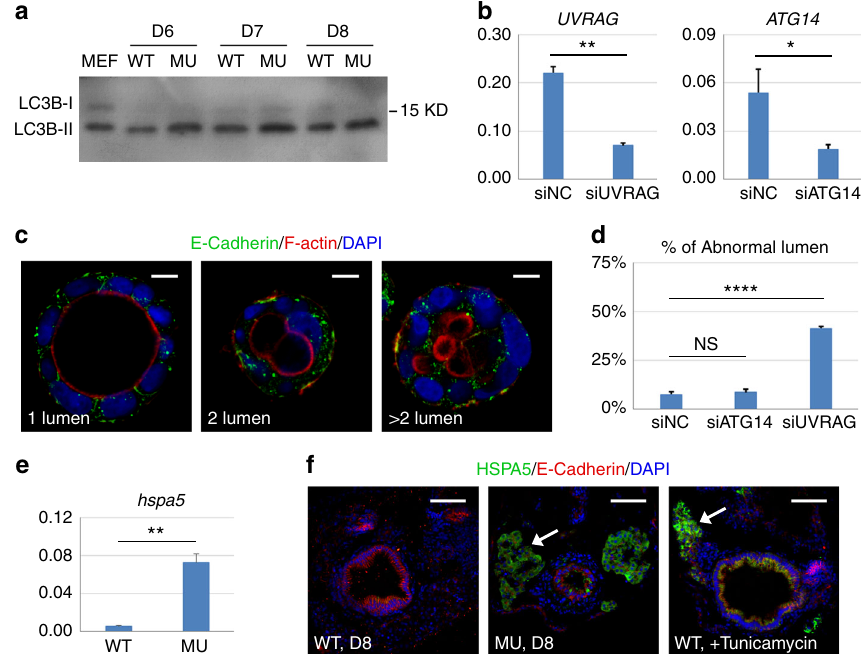
Fig. 7 Defects in endocytic traf fi cking is responsible for PIK3C3 de fi ciency-induced polarity defect. a Western blot analysis of LC3B in dissected gut. MEF lysate (total cell lysate of mouse embryonic fi broblasts under autophagic conditions) was used as the positive control. The LC3B antibody can detect the activated form of zebra fi sh LC3B (LC3B-II) but not LC3B-I. b qRT-PCR analysis for the ef fi ciency of siRNA to UVRAG or ATG14 in Caco2 cells. ACTB is the internal control and data represent mean ± SD from three biological repeats (* p < 0.05; ** p < 0.01 by unpaired two-tailed Student ’ s t -test). c , d UVRAG but not ATG14 knockdown induces abnormal lumen formation and E-Cadherin mis-localization in Caco2 cyst. Scale bar, 10 µ m. Data represent mean ± SD of the percentages of abnormal cyst (two or multiple lumens) from three biological repeats. NS, non-signi fi cant; **** p < 0.0001 by one-way ANOVA with Dunnett ’ s multiple comparison. e qRT-PCR analysis of ER stress gene hspa5 (heat shock protein family A member 5) in 8 dpf embryos. gapdh is the internal control and data represent mean ± SD from three independent repeats. p -value determined by unpaired two-tailed Student ’ s t -test (** p < 0.01). f Immuno fl uorescence staining of gut cross sections. In the pik3c3 mutant, HSPA5 signal is detected in liver (arrow) and a few cells in gut. Treatment of WT embryos with tunicamycin (an ER stress inducer, 1 µ M from 7 to 8 dpf) strongly induces HSPA5 in liver and gut. Scale bar, 50 µ